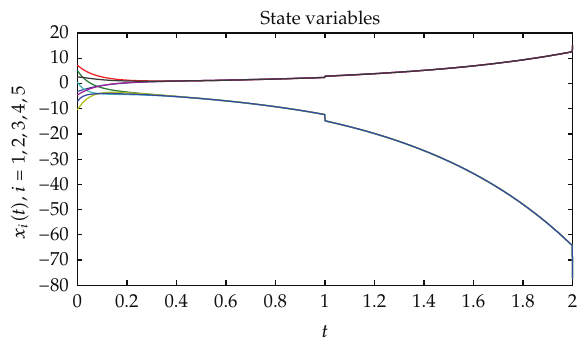
Figure 3: The state variables x i 1 (cid:7) t (cid:8) and x i 2 (cid:7) t (cid:8) with impulsive e ff